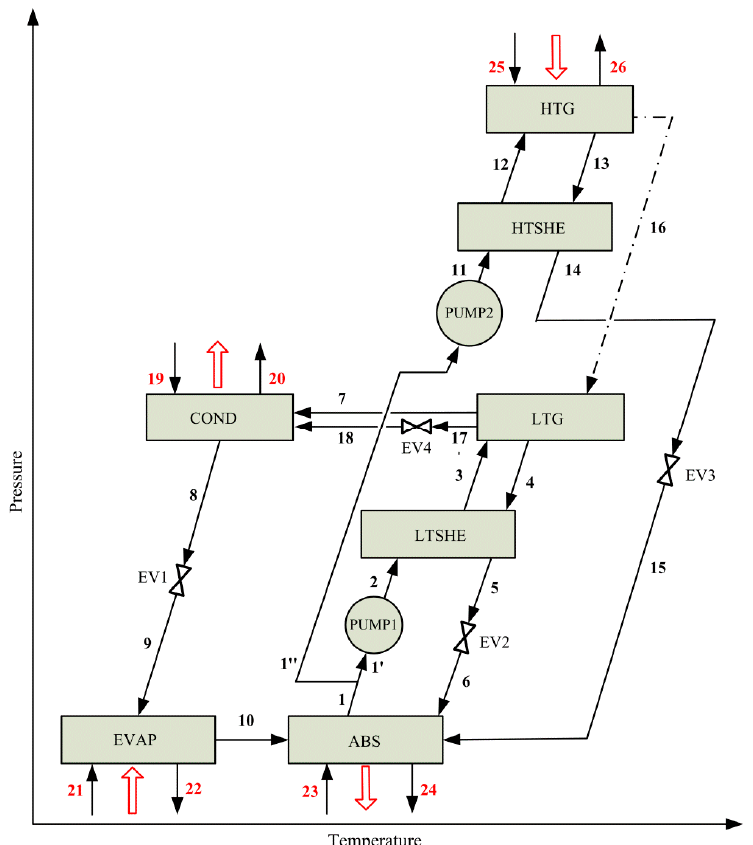
Figure 1. Schematic of the studied double-effect H 2 O-LiBr ARS. EV1, EV2, EV3 and EV4 represent expansion valves; EVAP evaporator, ABS absorber; PUMP1 and PUMP2 solution pumps; LTSHE and HTSHE low and high temperature solution heat exchangers, respectively; LTG and HTG low- and stream associated to the refrigerant formed in